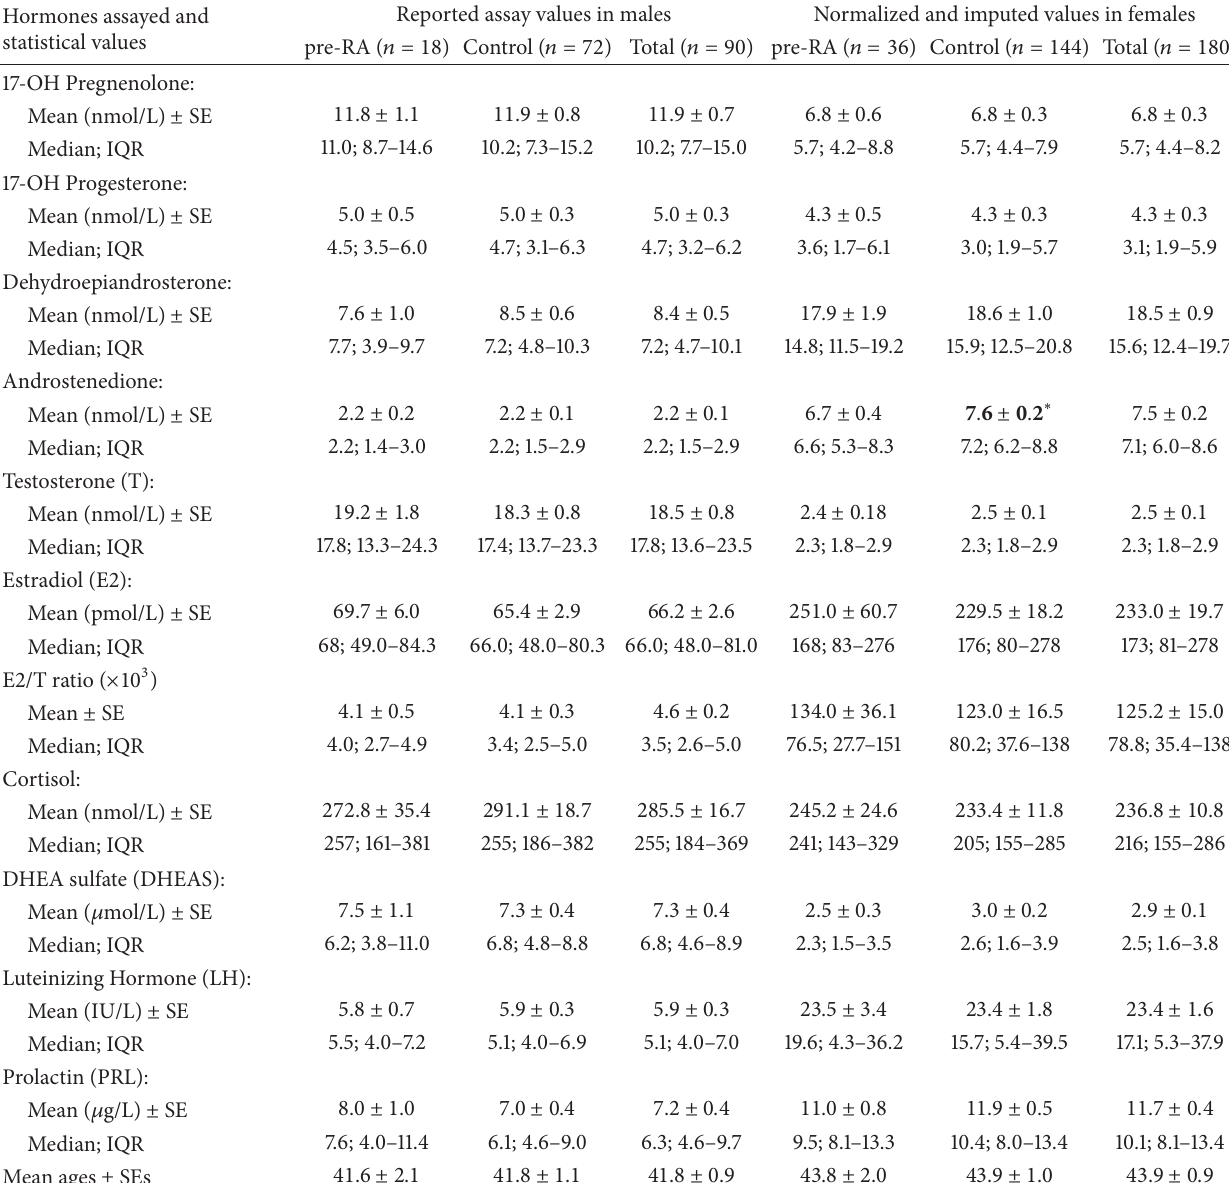
Table 1: Hormonal values in males of reported assays and normalized, imputed values in females to full sample sizes. Reported assay values in males Normalized and imputed values in Hormones assayed and statistical values